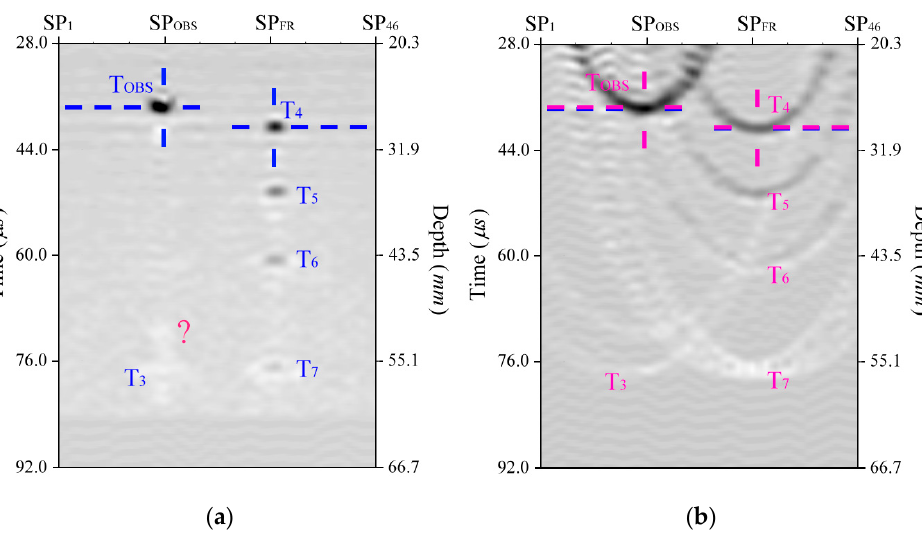
Figure 4. ( a ) Original B-mode scan data. Except for T 2 and T 3 , the other targets are all echo imaged. The intersection of the dark blue dashed lines indicates the image of T OBS . A phantom echo which is question marked at the lower center position of SP OBS is identified as a multiple of T OBS . ( b ) Restored image of ( a ) which is processed by SAFT. All of the target images, except for T 2 and T 3 , are well restored. The intersections of the dark blue dashed lines and pink dashed lines show the position of T OBS before and after the SAFT process.